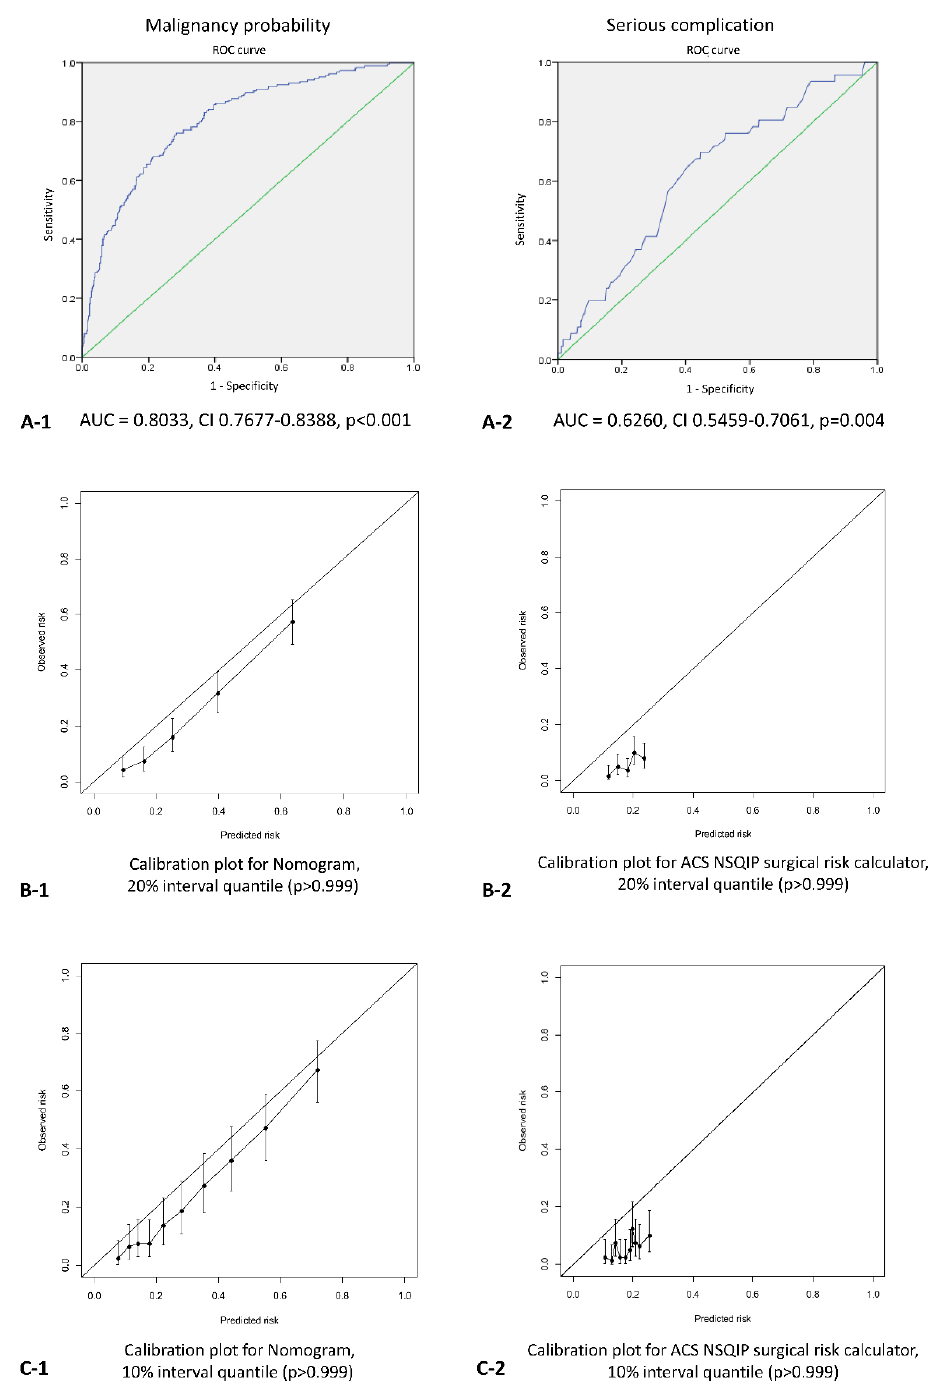
Figure 2. ROCs ( A ) and the Hosmer–Lemeshow tests in the 20% ( B ) and 10% ( C ) of the nomogram (1) and ACS NSQIP surgical risk calculator (2) in the study